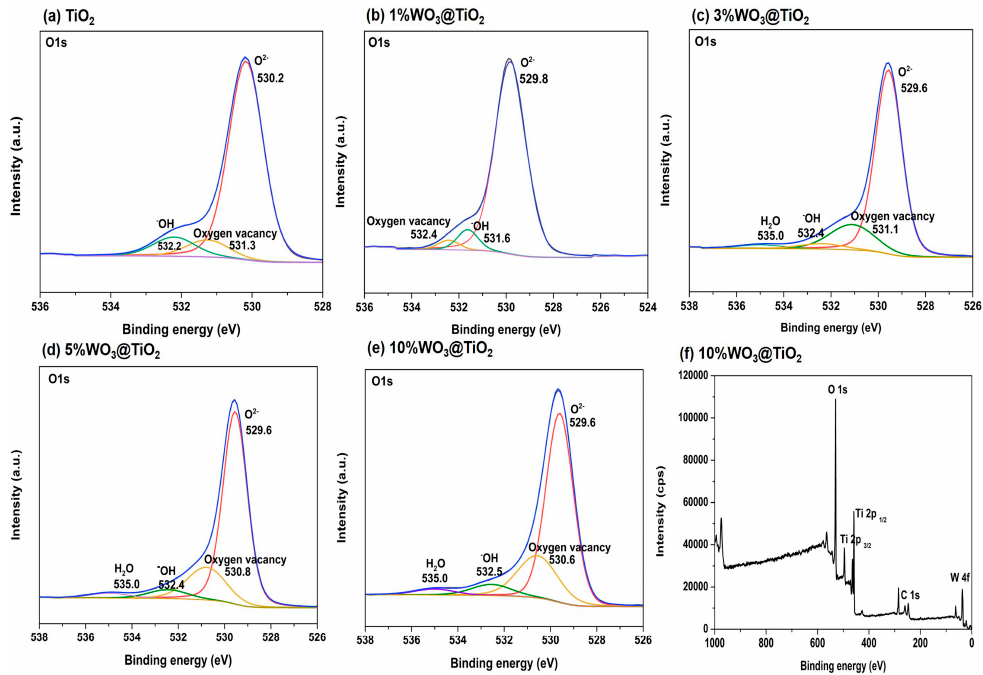
Figure 1. High-resolution XPS spectra of the synthesized TiO 2 ( a ); WO 3 @TiO 2 composites ( b – e ); and a wide scan XPS spectrum of 10%WO 3 @TiO 2 ( f ). Table 1. Bandgap energy values, crystallite sizes, oxygen vacancies, surface areas, and rates of MB degradation ( k ) of the various metal oxides prepared via sol–gel process.